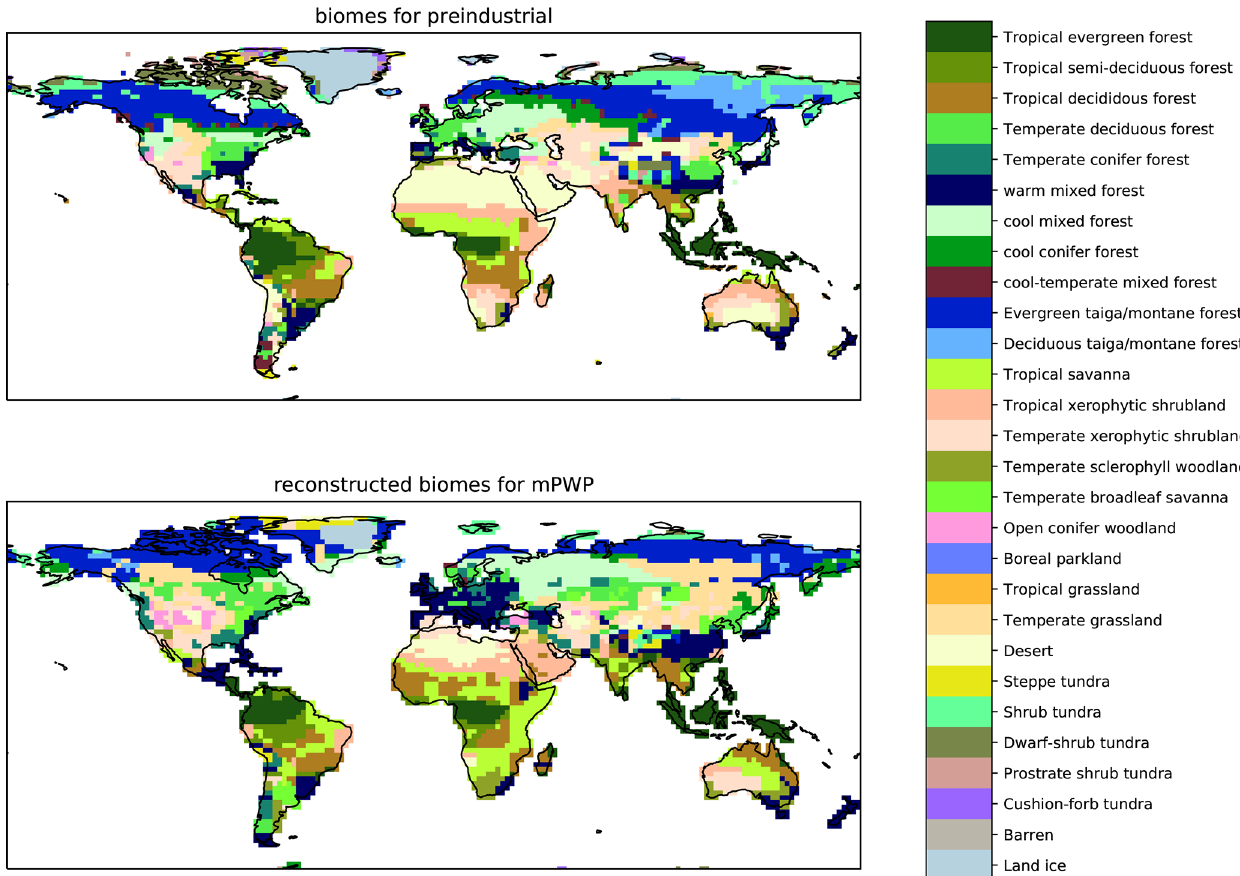
Figure 7. A comparison of modern biomes with the reconstructed biomes for the mPWP (Salzmann et al., 2008).